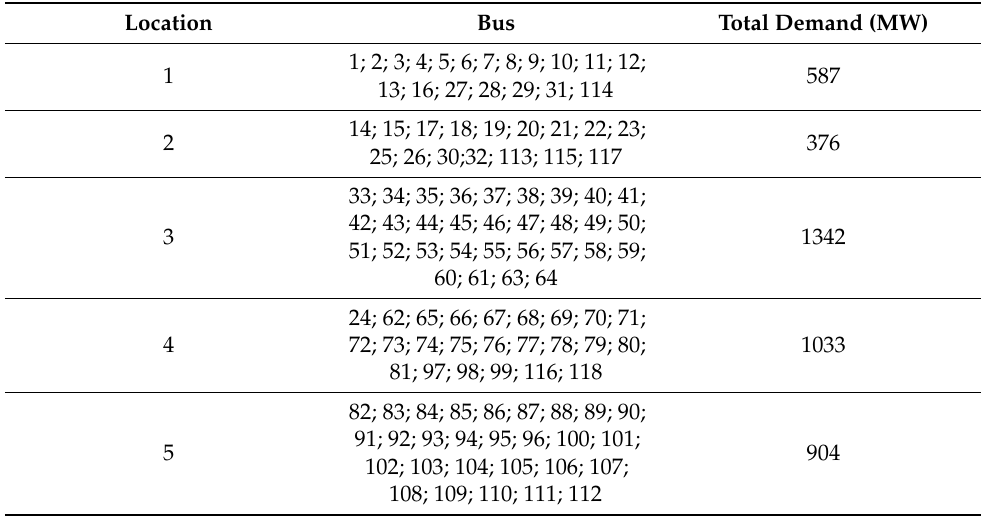
Table 9. Location